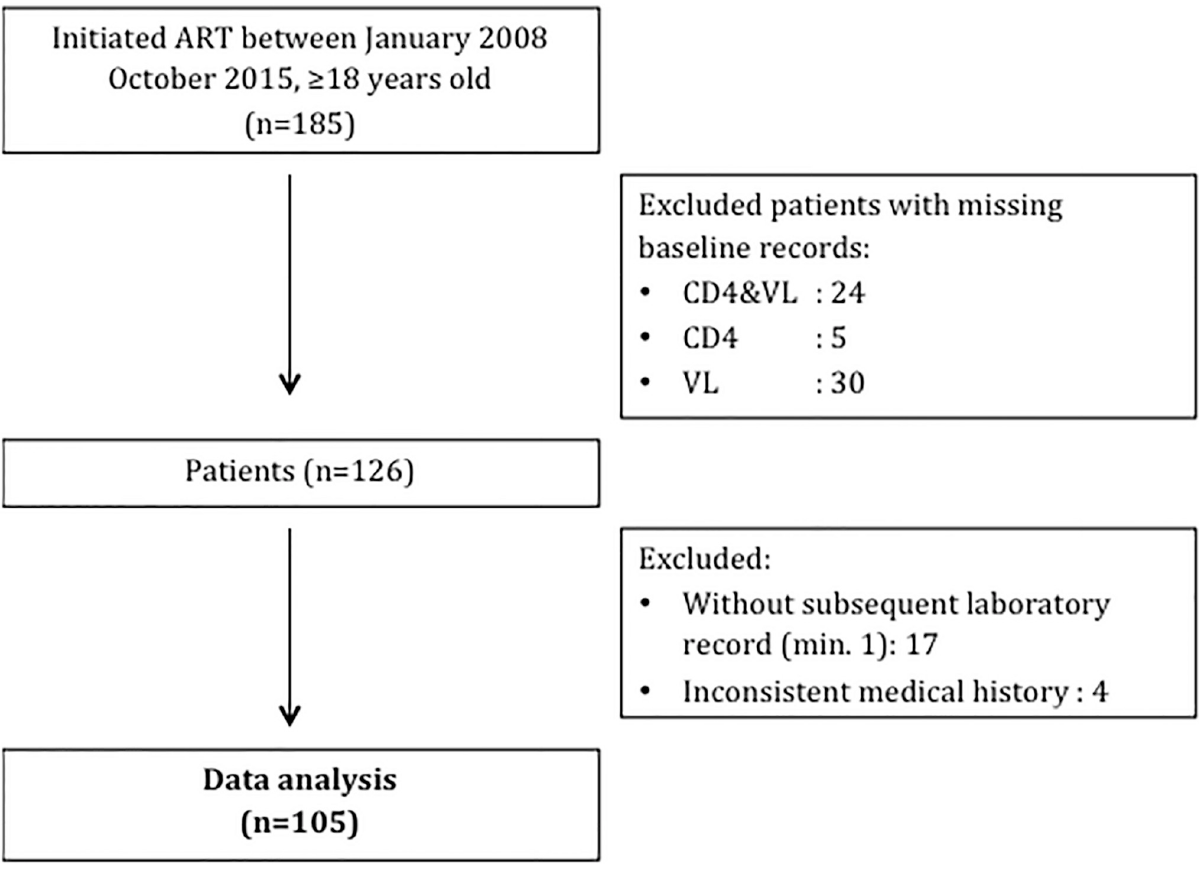
Fig 1. HIV treatment outcomes study